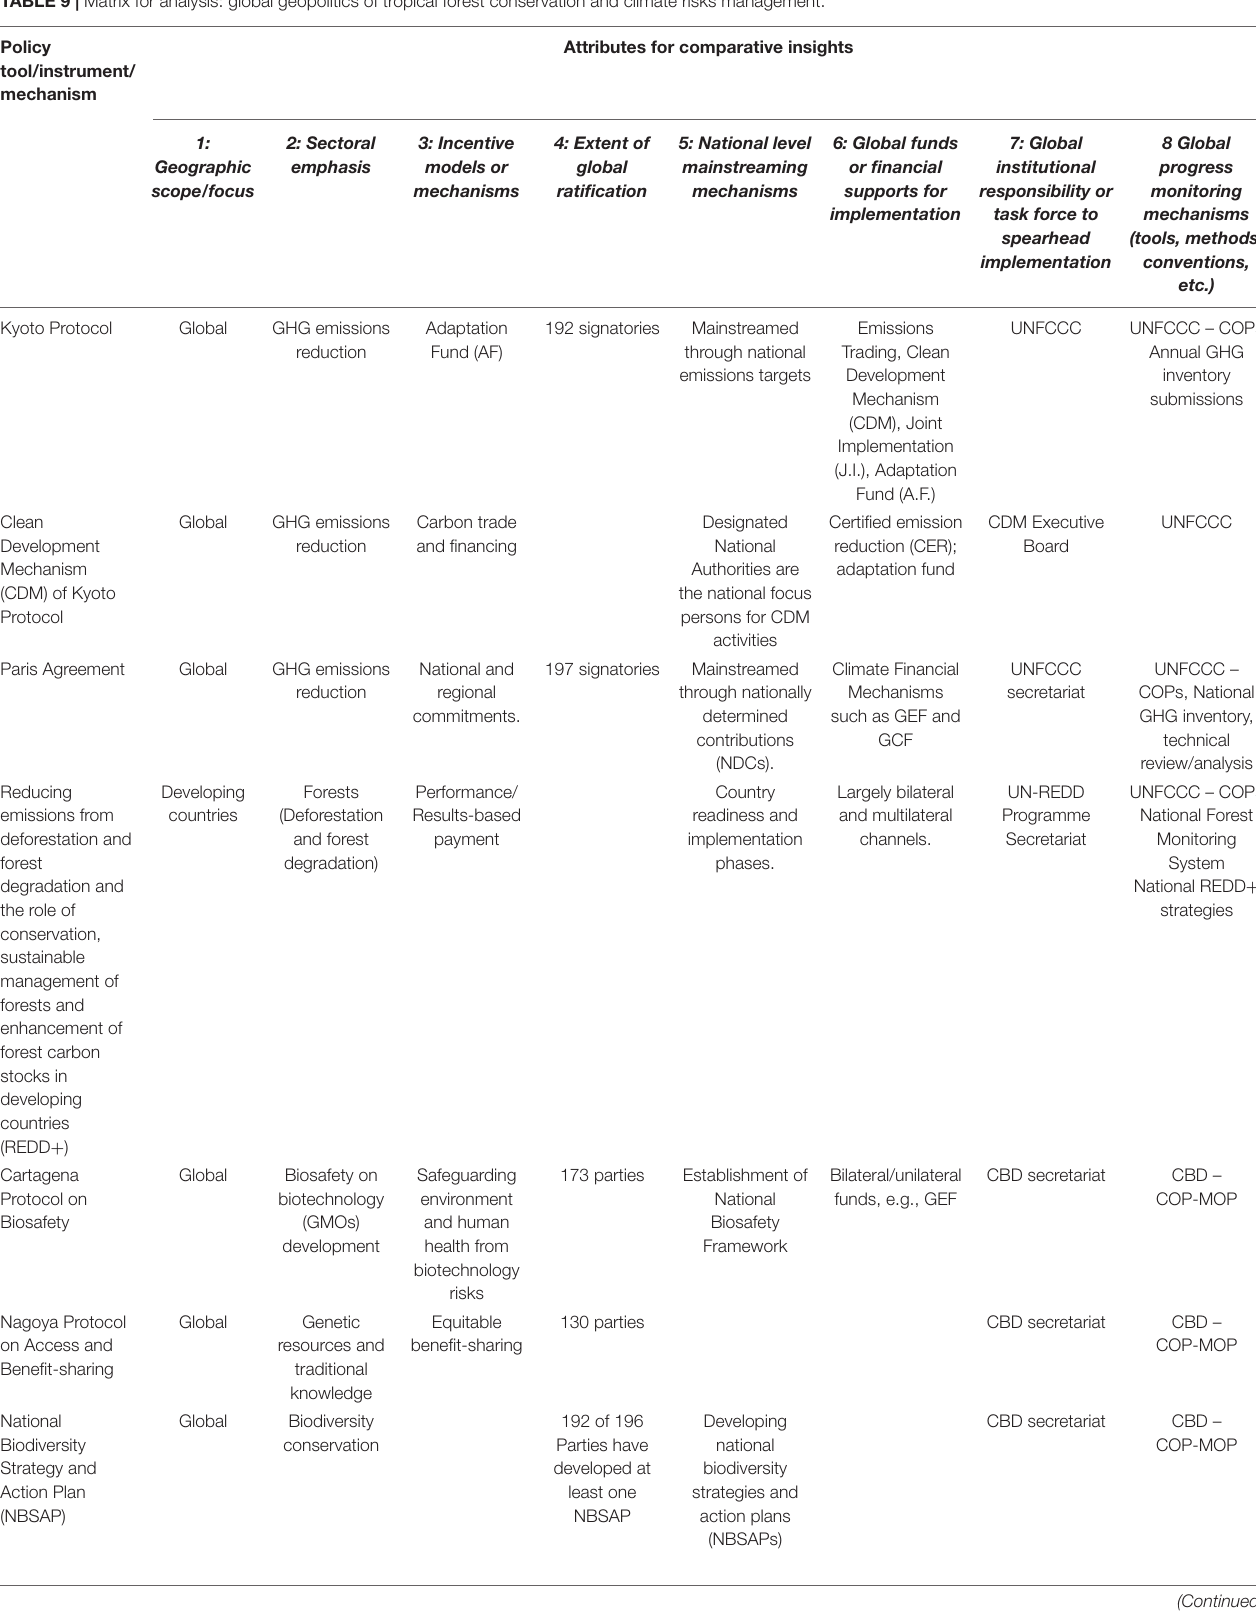
TABLE 9 | Matrix for analysis: global geopolitics of tropical forest conservation and climate risks management. Policy